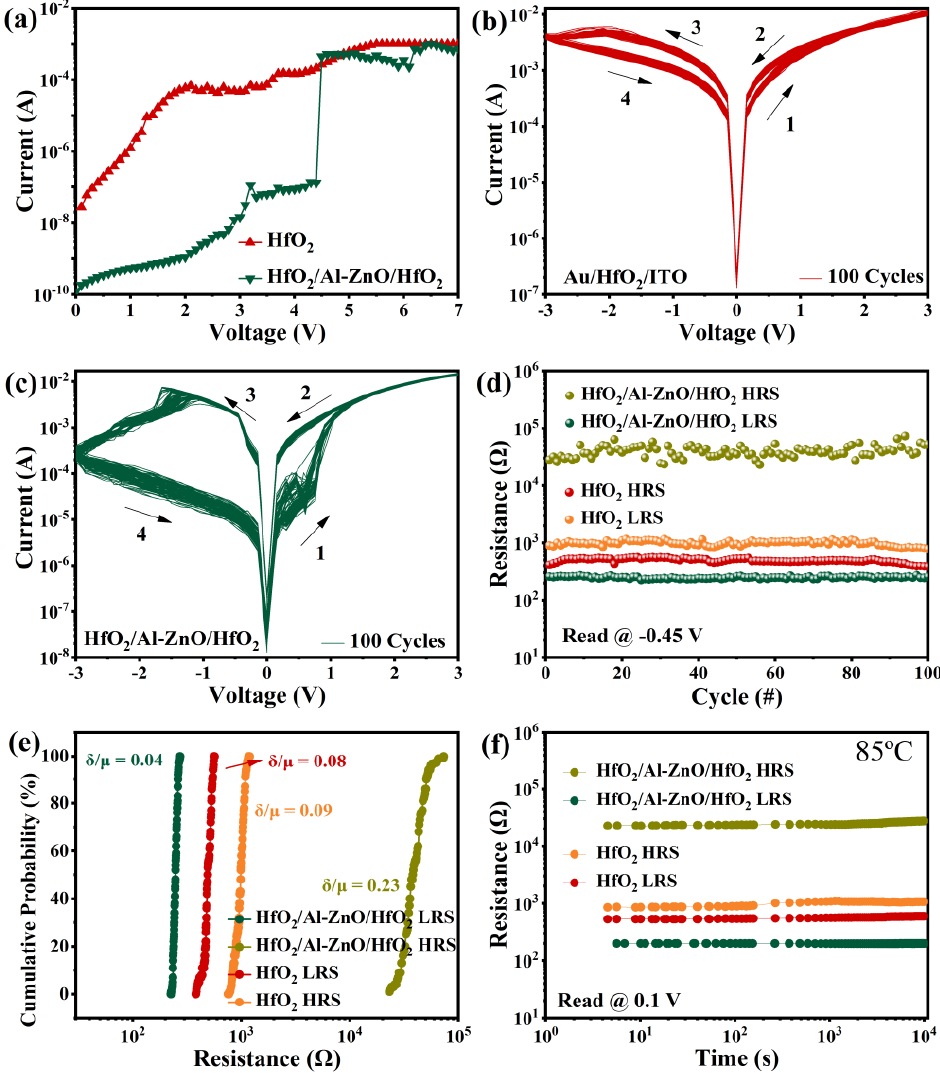
Figure 3. ( a ) Forming operations; ( b ) I–V characteristics of Au/HfO 2 /ITO memory device; ( c ) Au/HfO 2 /Al-ZnO/HfO 2 /ITO memory devices; ( d ) high-/low-resistance states of Au/HfO 2 /ITO and Au/HfO 2 /Al-ZnO/HfO 2 /ITO devices for 100 cycles, read at − 0.45 V; ( e ) cumulative probability distribution of the LRS/HRS resistance of the Au/HfO 2 /ITO and Au/HfO 2 /Al-ZnO/HfO 2 /ITO devices; and ( f ) retention of Au/HfO 2 /ITO device and Au/HfO 2 /Al-ZnO/HfO 2 /ITO device, read at 0.1 V.